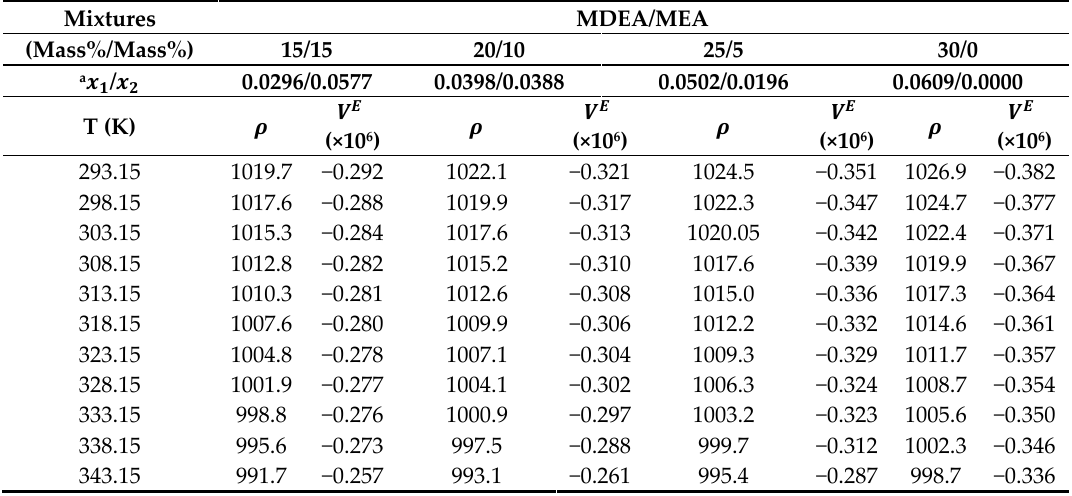
Table 3. Densities 𝜌 (kg · m −3 ) and excess molar volume 𝑉 𝐸 (m 3 · mol −1 ) of MDEA (1) + MEA (2) + H 2 O (3) mixtures.